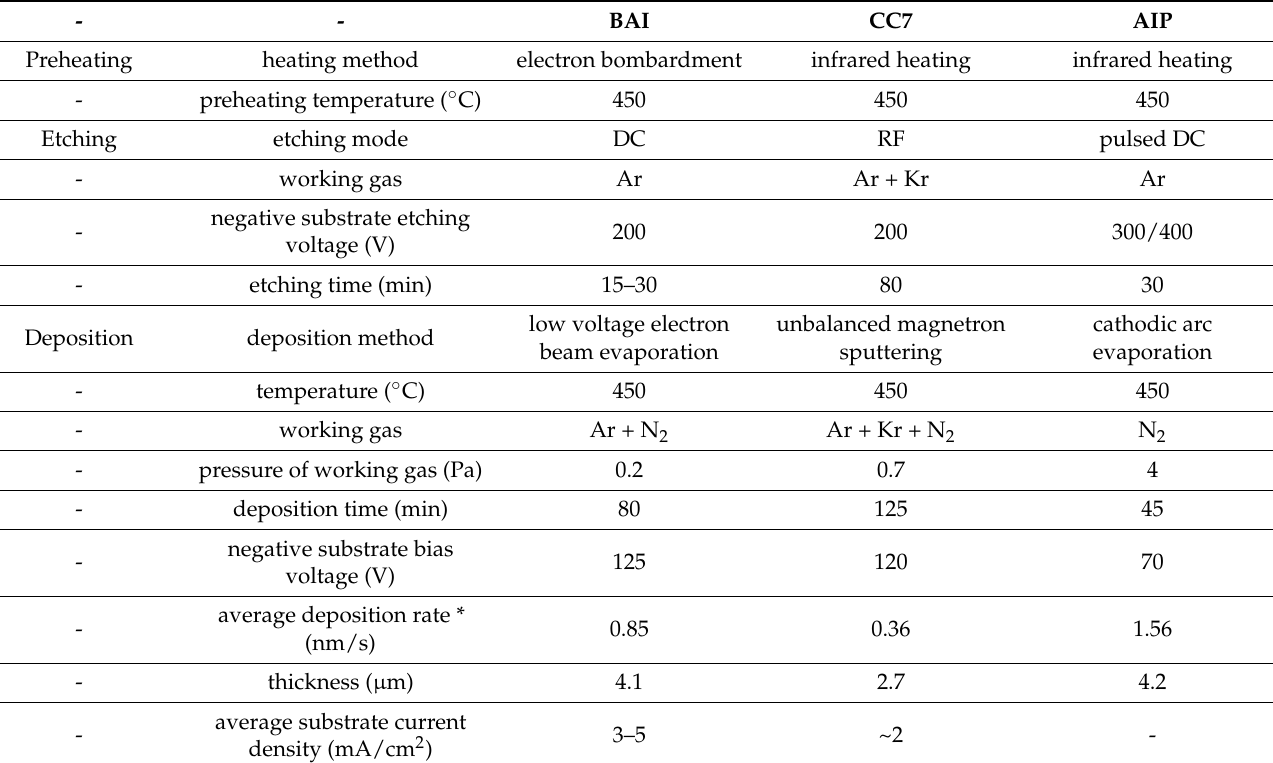
Table 1. Deposition methods and process parameters used for the preparation of TiN hard coatings. The deposition rates and ion current density are averages since all deposition techniques exhibited both spatial and temporal variations during a given deposition run as well as from one run to another run (depending on batching